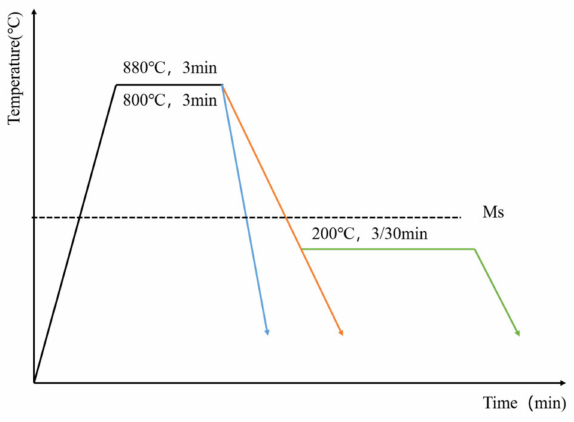
Figure 2. Schematic diagram of heat